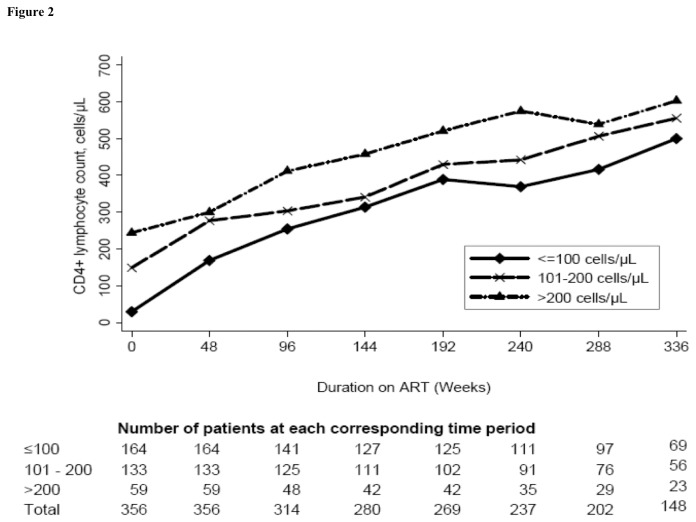
Median CD4 count over time stratified by baseline CD4 count.The full line with diamonds represents people with baseline CD4 count ≤100 cells/µL.The long dash line with ‘x’ s represents people with baseline CD4 count 101-200 cells/µL.The long dash-dotted line with triangles represents people with baseline CD4 count >200 cells/µL.